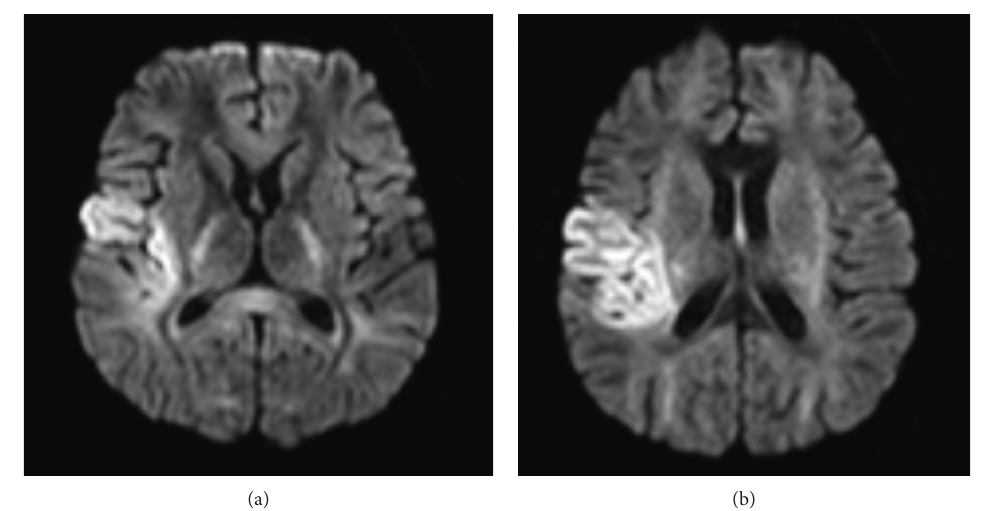
Figure 2: DWI: hyperintensity over right temporal lobe and insular